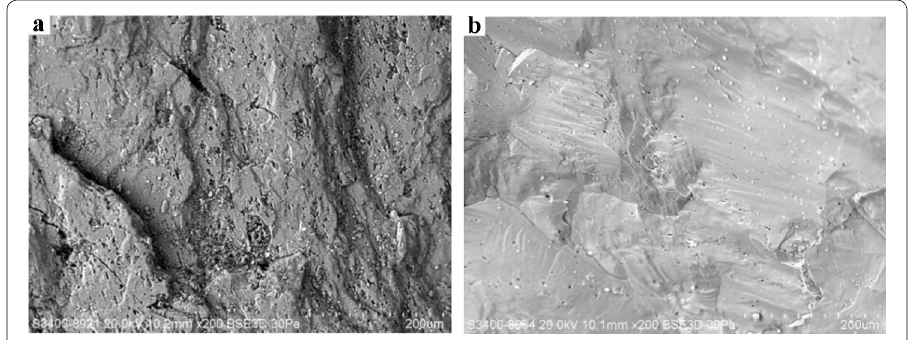
Fig. 3 Scanning electron microscope images for completely decomposed granite with size of 0.6–1.18 mm at magnification of 200: a feldspar; b ×